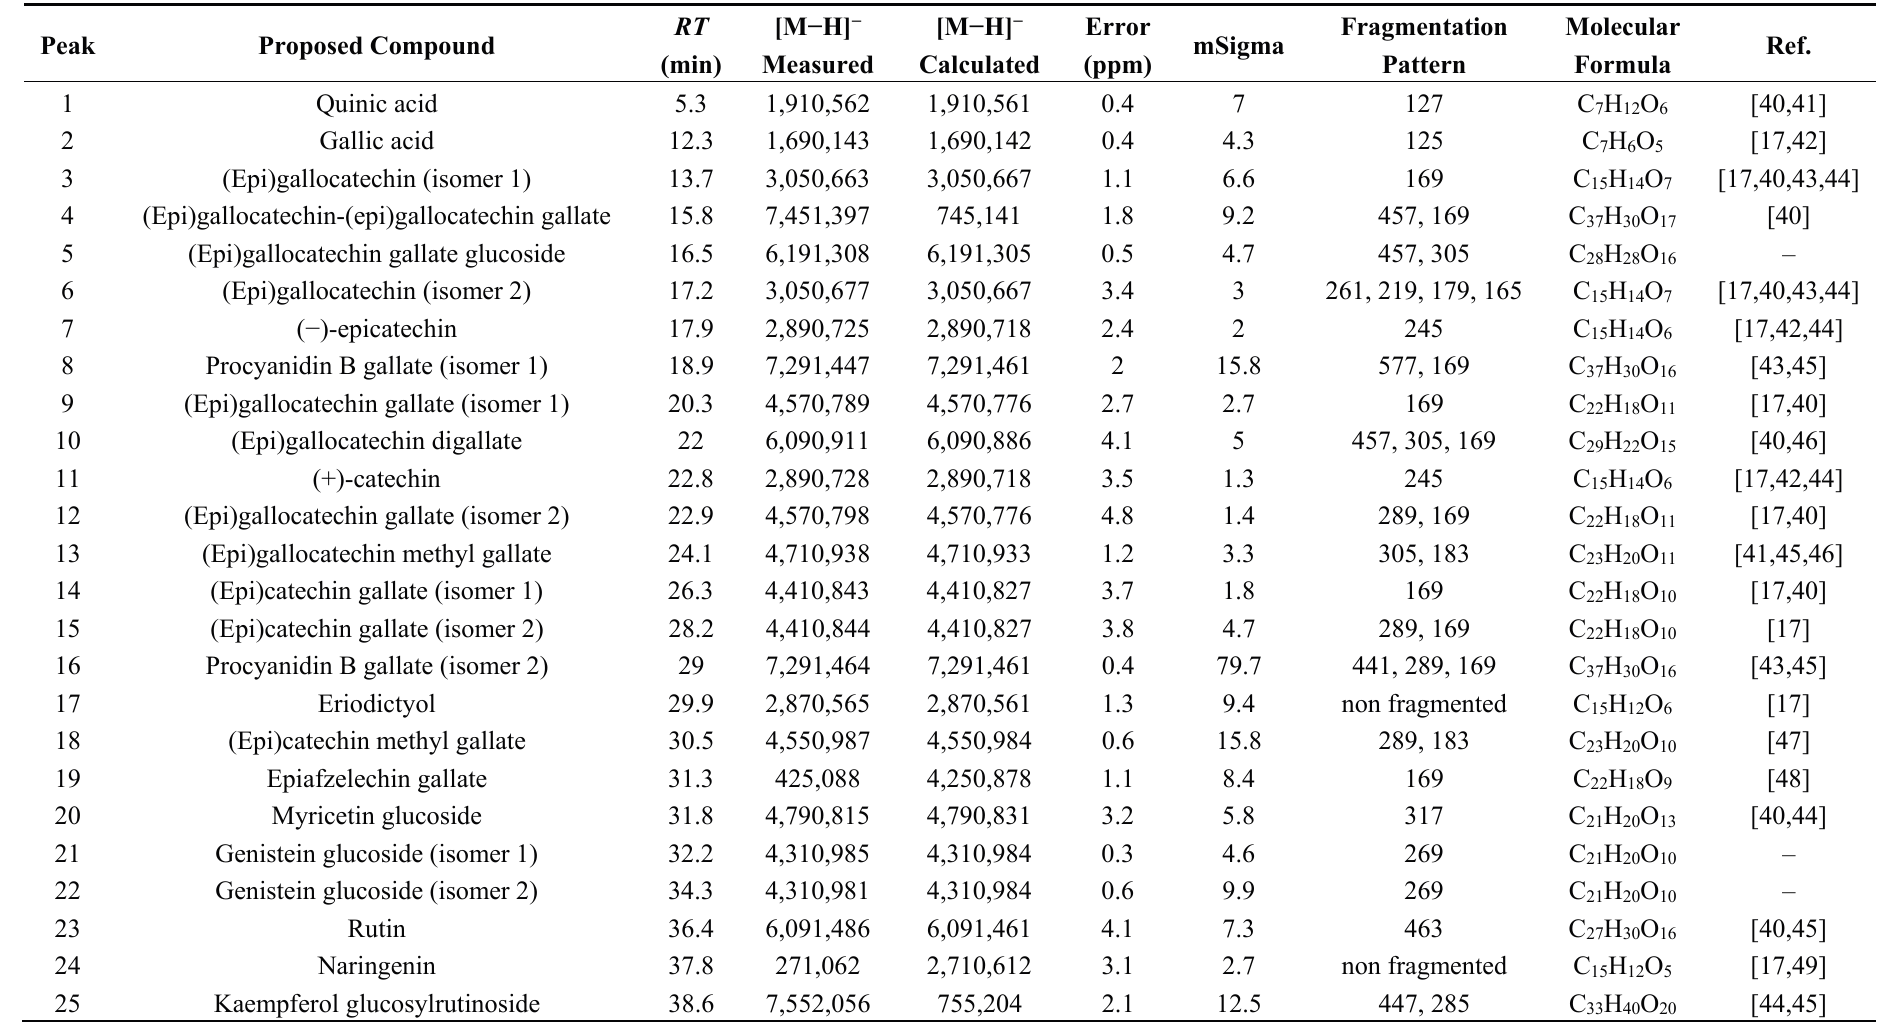
Table 2. Retention times and mass spectral data of the compounds characterized in green tea extract by HPLC–ESI-QTOF-MS and MS/MS in negative